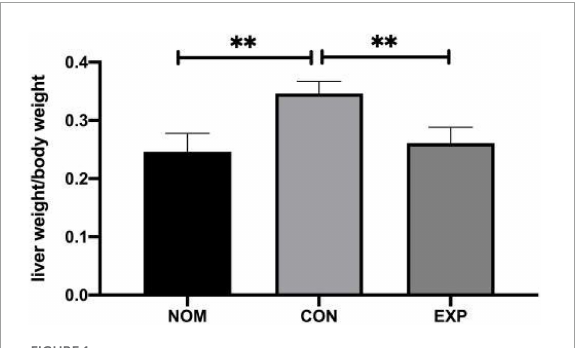
FIGURE1 β -sitosterol lowers the liver index of atherosclerosis (AS) mice. Values are presented as the mean ± SD. ∗∗ p < 0.01.